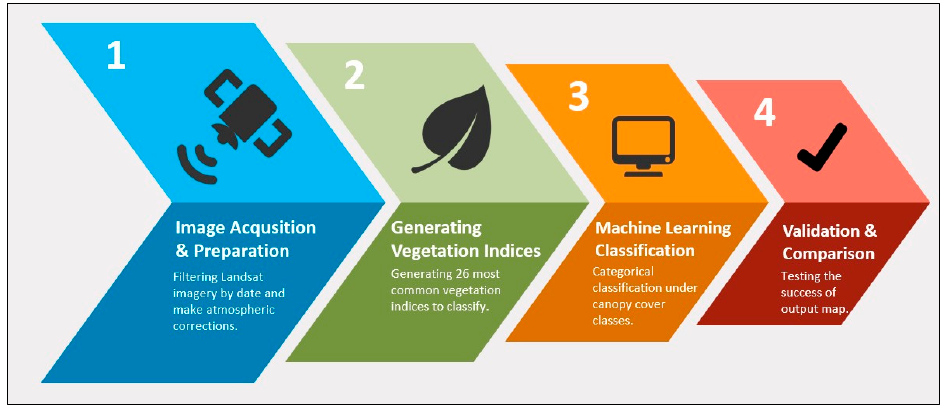
Figure 4. Phases of the canopy cover estimation model.